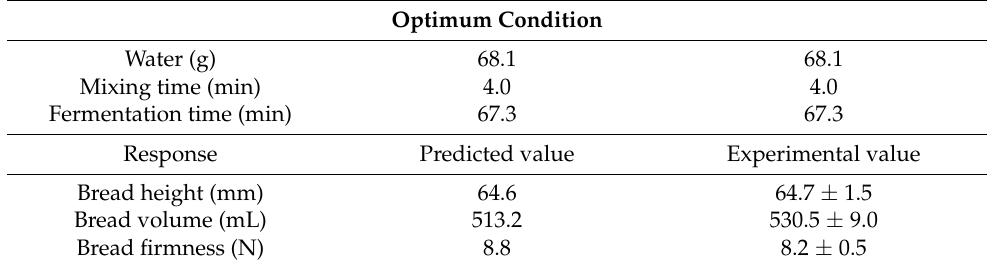
Table 7. Predicted and experimental values of response at optimized